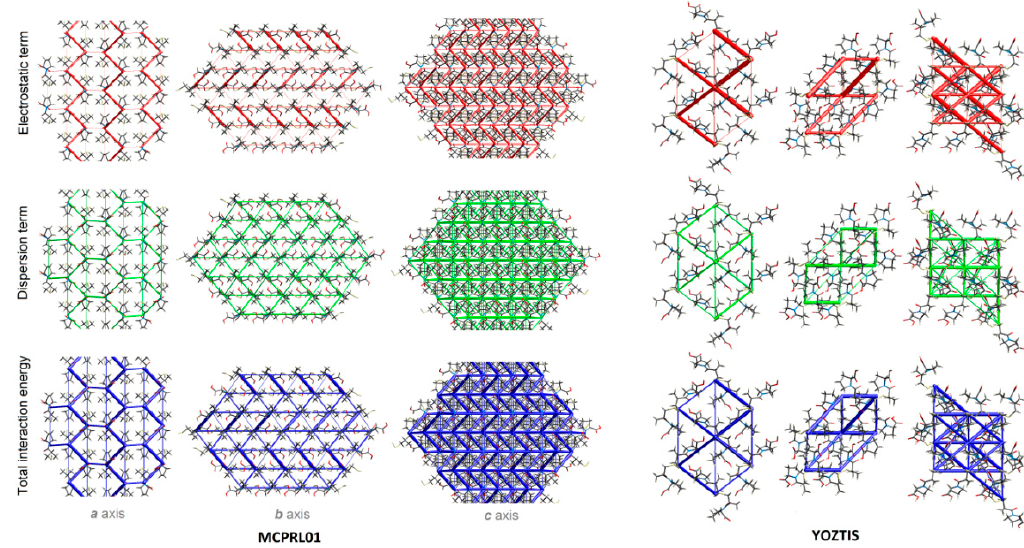
Figure 23. Energy frameworks of captopril (on the left) and captopril disulfide (on the right) corresponding to the electrostatic and dispersion energy components, and the total energy framework along the a, b and c -axis (the tube size: 300).